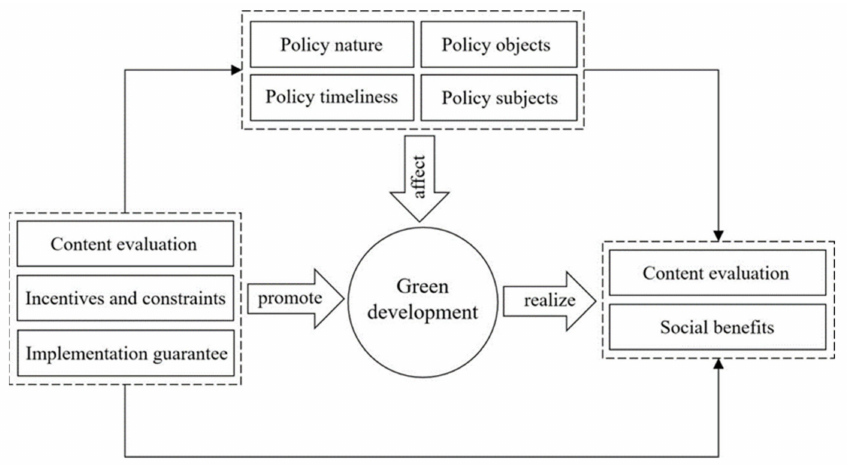
Figure 1. Relationships between different variable parameters.